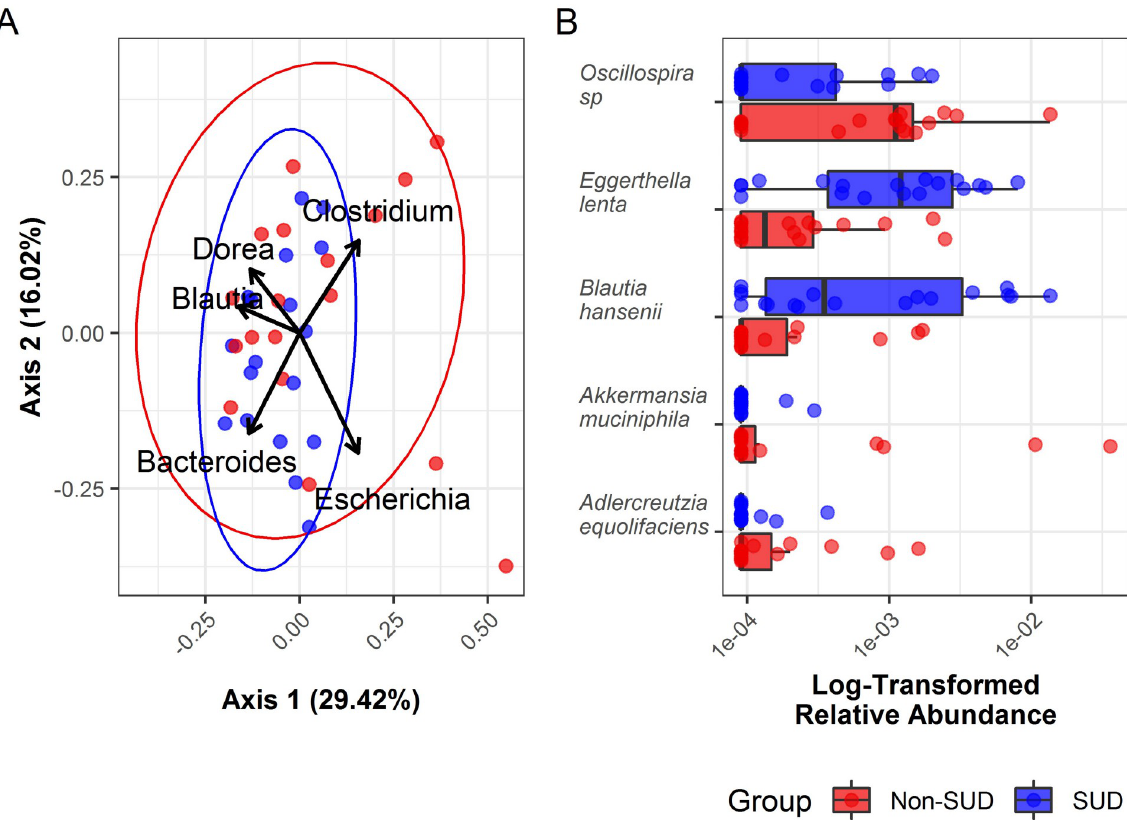
Fig 4. A. Projections of major microbial species contributing to the groups in the ordination plot. Biplot arrows indicate the top five genera abundances that accounted for the most variation in the ordination plot. B. The log-transformed relative abundances of bacterial taxa detected to be differentially abundant between groups by ANCOM are depicted by boxplot. The median value, first and third quartiles, and confidence interval in each group are